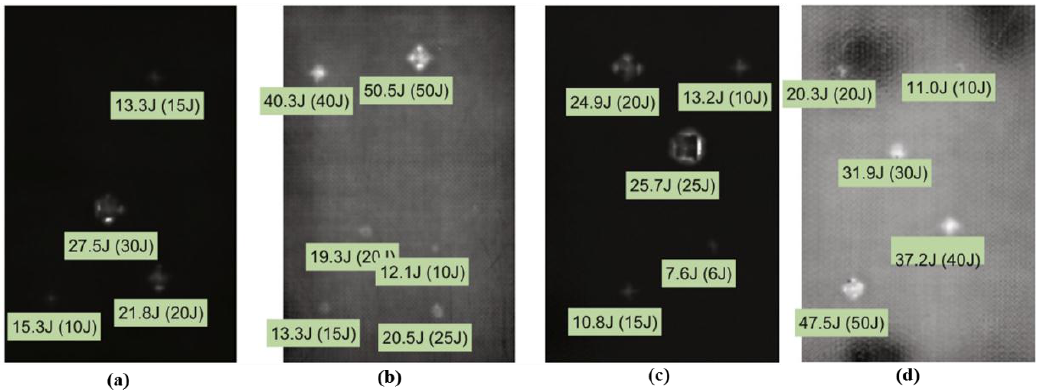
Figure 24. Estimated impact energy using artificial neural networks: specimen 2 front side ( a ), specimen 2 backside ( b ), specimen 3 front side ( c ), specimen 3 backside ( d ) [76]. Reprinted/reproduced with permission from Elsevier.